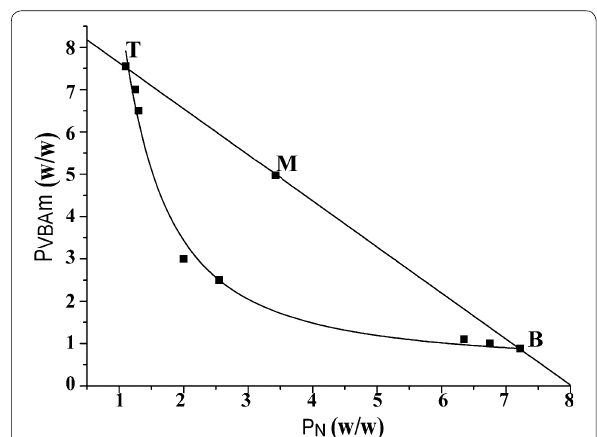
Fig. 8 Phase diagram of P VBAm / P N ATPS. The Cloud Point Method was at original pH 5.12 and 25 °C. M represents the composition of the polymers. T and B represent the concentrations of P VBAm and P N in each